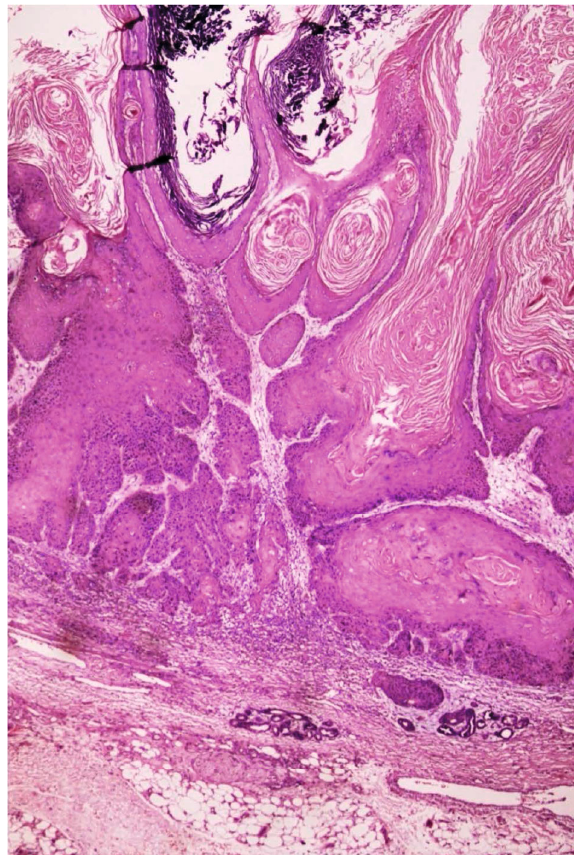
Figure 1: Squamous cell carcinoma. Blunt-type intradermal invasion of well-di ff erentiated tumor nests (H&E, ×